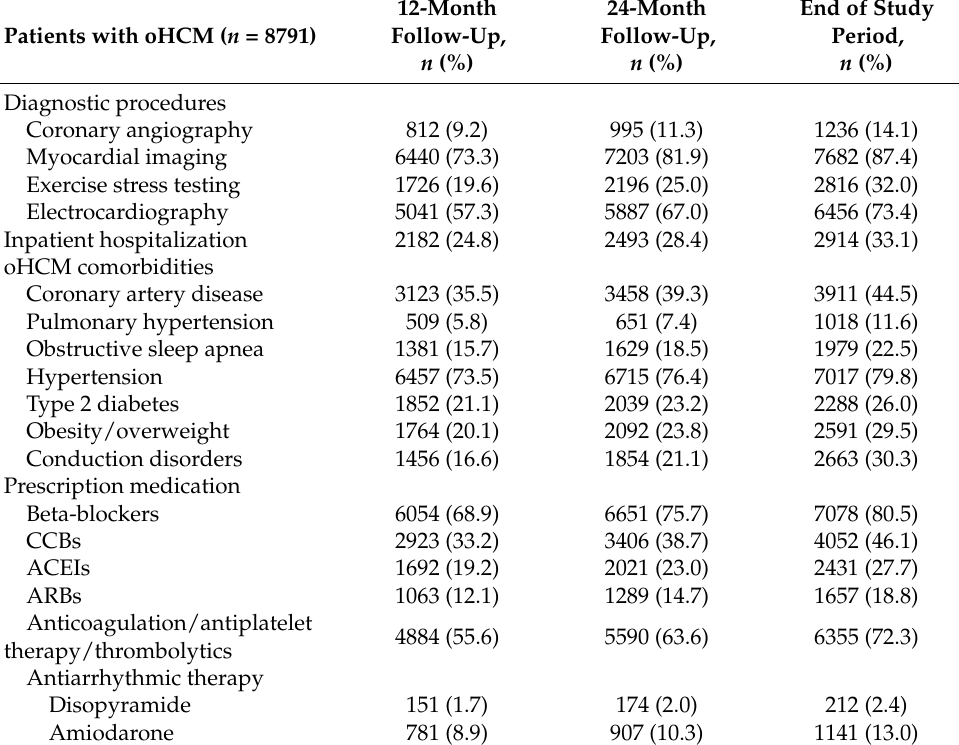
Patients with oHCM ( n =